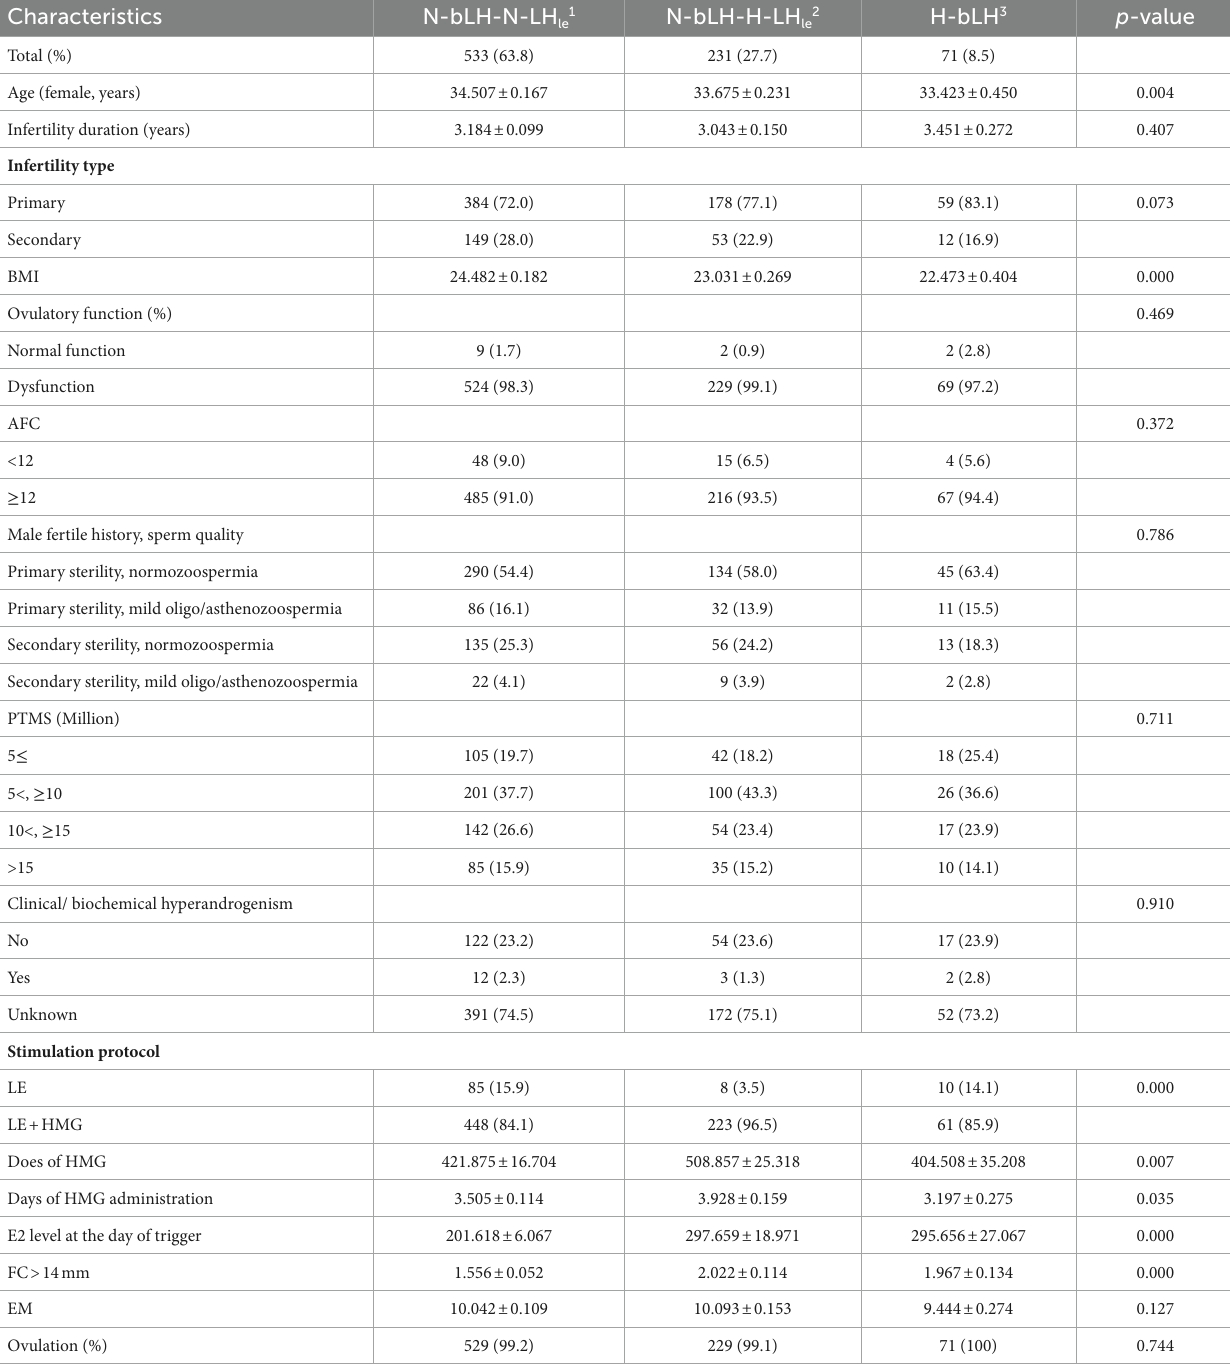
TABLE 1 Baseline characteristics, ovulation induction